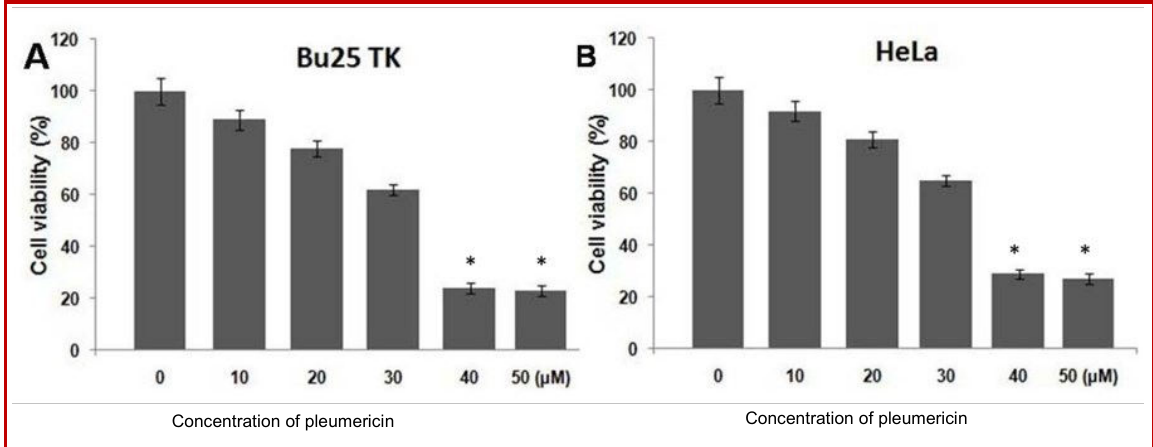
Figure 2: Inhibition of cell viability in cervical carcinoma cells by plumericin. The cervical carcinoma cell lines, Bu25TK and HeLa were incubated with various concentrations of plumericin for 12, 24, 36 and 48 hours followed by analysis using MTT assay. The data presented are the mean ± S. D. of three independently performed experiments.*p<0.05, in comparison to the control cells. MTT, 3-(4,5-dimethyl- thiazol-2-yl)-2,5-diphenyltetrazolium